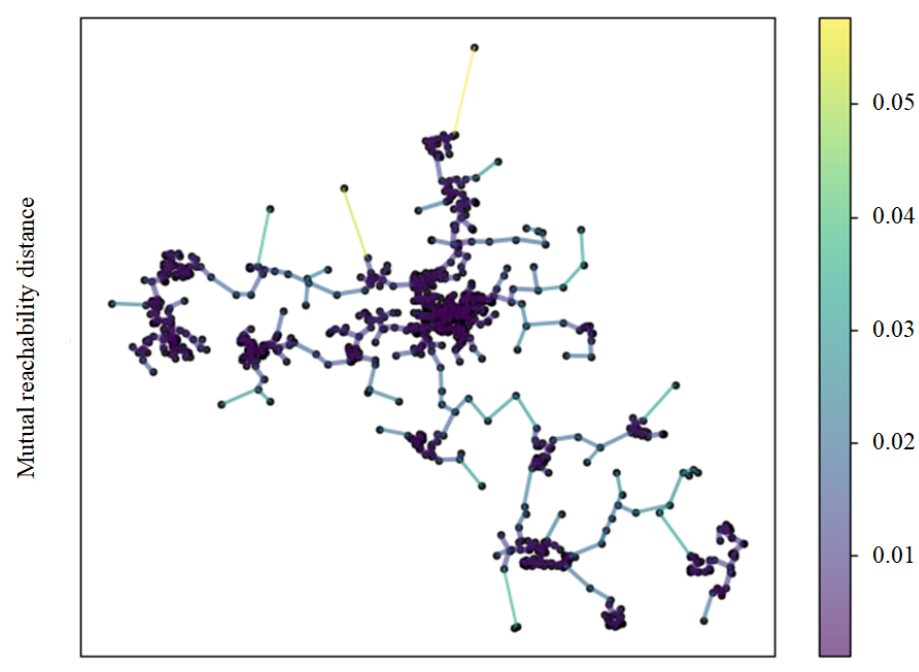
Figure 8. MST of data points using Prim’s algorithm.